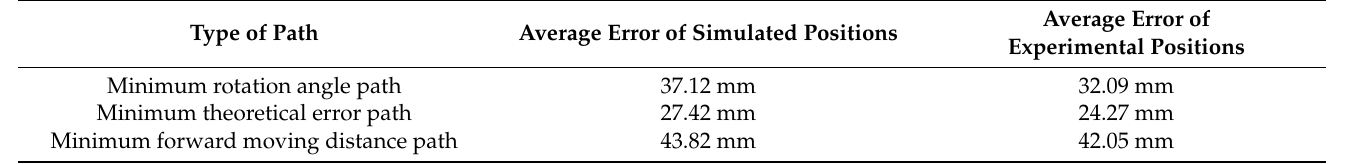
Table 3. Average position error of simulation and experiment